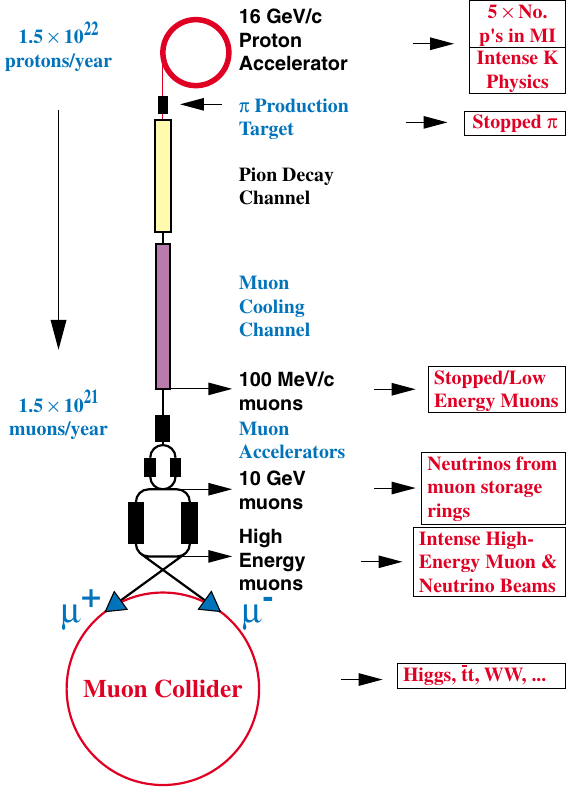
FIG. 32. (Color) Schematic of a